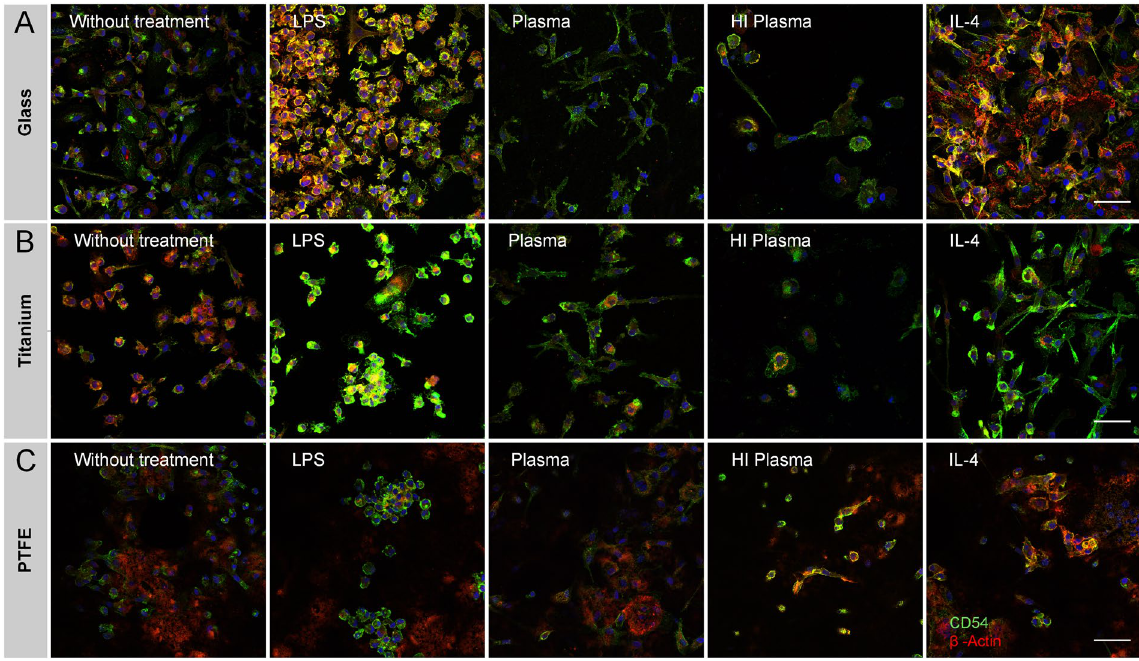
Figure 4. Immune-histological staining of intercellular adhesion molecule CD54 (green) and β -Actin (red) illustrated morphological changes in dependency of test conditions and material on ( A ) glass, ( B ) titanium and ( C ) PTFE. An uneven topography and a long working distance prohibited to capture sharp images on silicone and PE surfaces. The scale bar depicts 50 µ m and is valid for all images. The following abbreviations are used: HI for heat-inactivated.